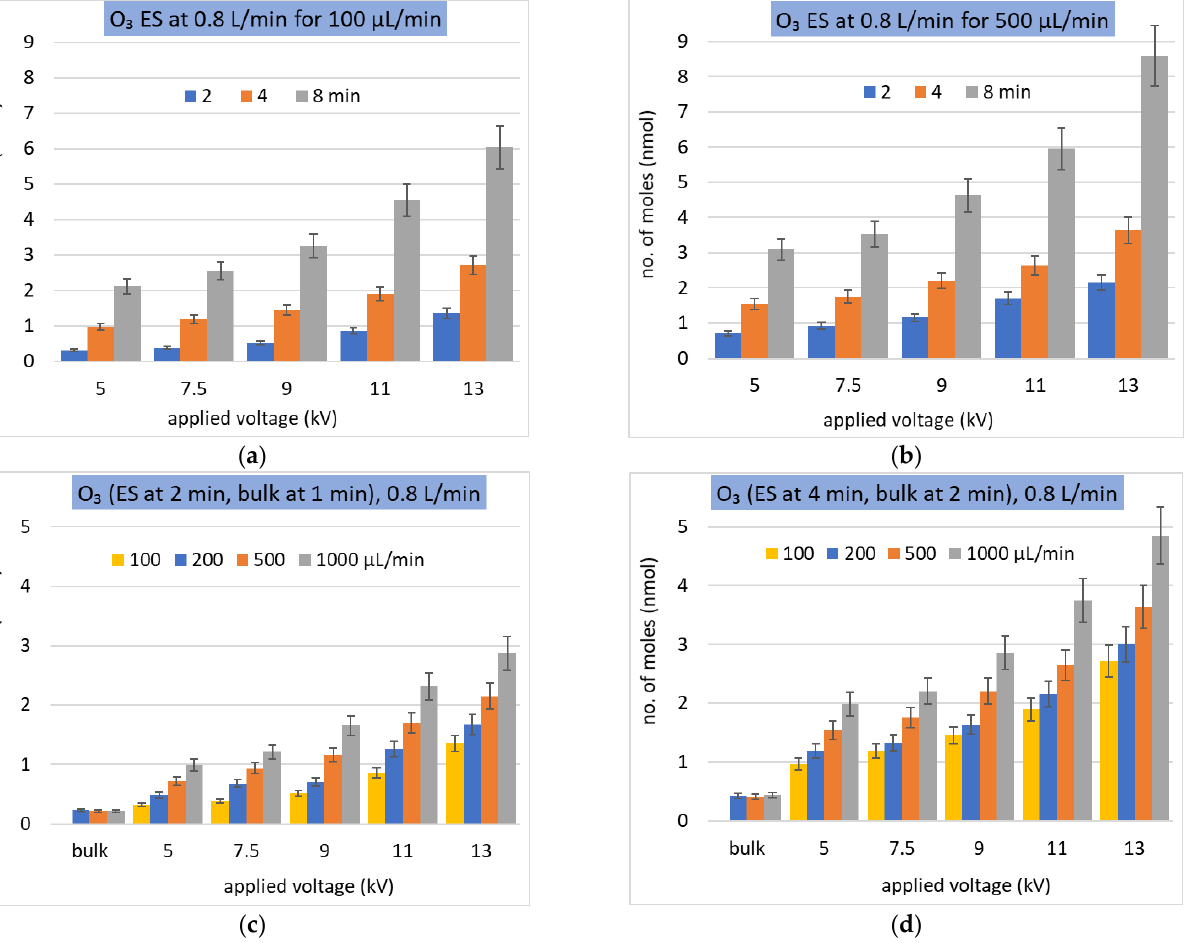
Figure 7. Solvation of O 3 as a molar number of dissolved molecules in ES at a constant gas flow rate (L/min). ( a , b ) two values of constant Q w (µL/min) and different treatment times (min); ( c , d ) different Q w (µL/min) during different treatment times (min) in ES and bulk water.